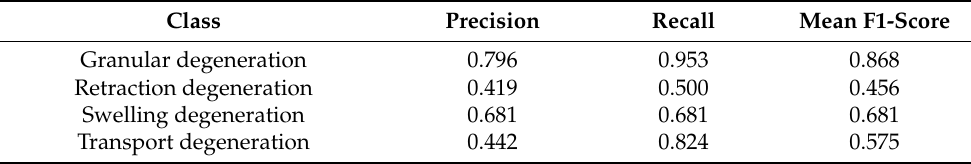
Table 4. Ten-fold cross-validation of the four morphological patterns of AxD. Class Precision